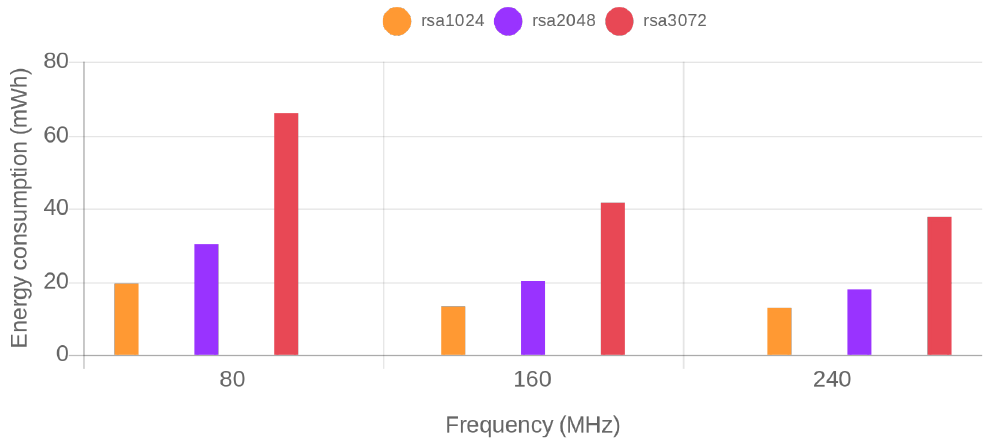
Figure 4. Energy consumption grouped by SoC frequency for the different tested RSA key